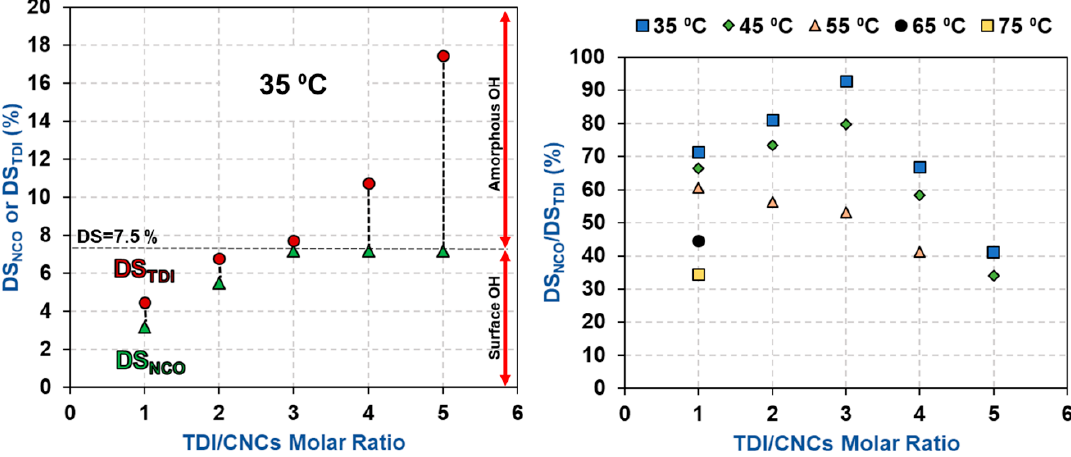
Figure 4. The impact of TDI/CNCs molar ratio on DS NCO , DS TDI , and carbamation efficiency (DS NCO / DS TDI ).